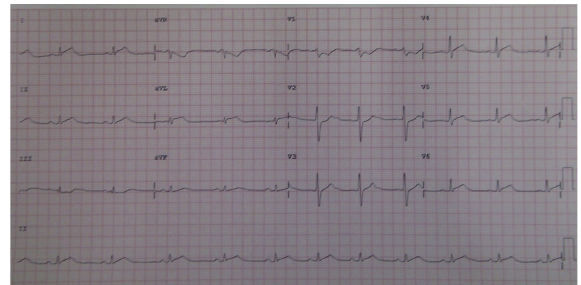
Figure 1: ST-segment elevation is revealed over the precordial V3 − V6 lead.